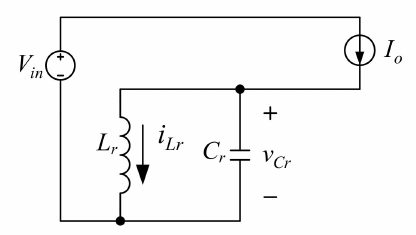
Figure 4. Equivalent circuit in state